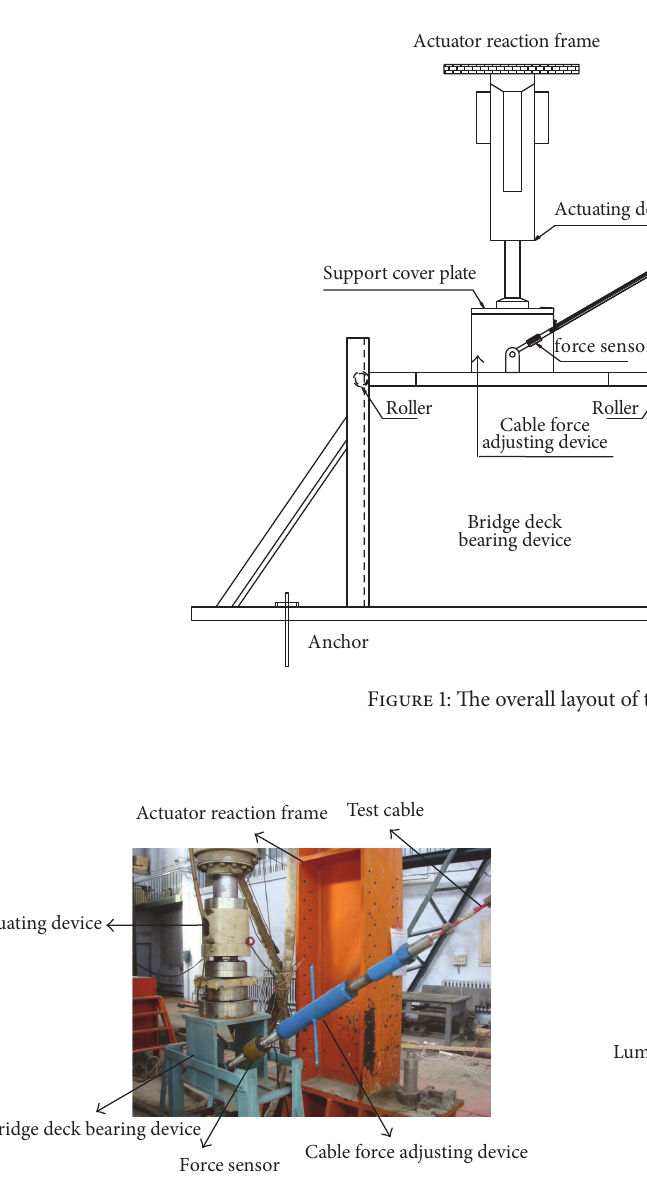
Figure 2: The photo of the joints between bridge and support.